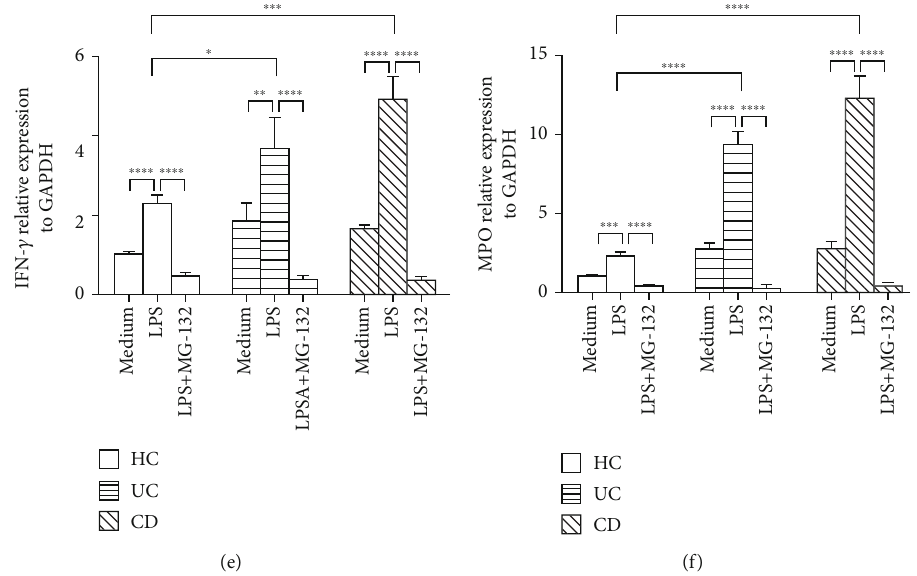
Figure 4: MCPIP-1 degrades the mRNA levels of proin fl ammatory cytokines in neutrophils. Peripheral neutrophils ( 5 × 10 6 ) were isolated from patients with active CD ( n = 10 ), active UC ( n = 10 ), and HC ( n = 10 ) and stimulated in vitro with LPS (100ng/mL) in the absence or presence of MG-132 (20 μ M) for 3 hours. Cells were then harvested, and expression of IL-1 β (a), IL-6 (b), TNF- α (c), IL-8 (d), IFN- γ (e), and MPO (f) was analyzed by quantitative RT-PCR and normalized to GAPDH. ∗ P < 0 : 05 , ∗∗ P < 0 : 01 , ∗∗∗ P < 0 : 001 , and ∗∗∗∗ P < 0 : 0001